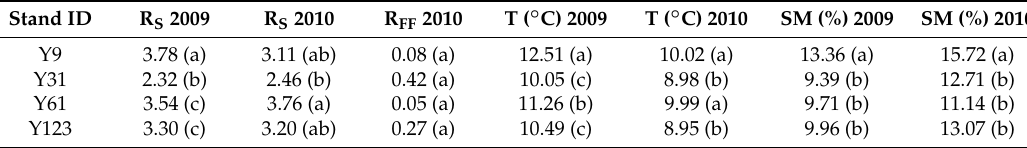
Table 3. Mean values of total soil respiration (R S ), volumetric soil moisture (SM), soil temperature (T), and forest floor respiration (R FF ) before experimental litter removal (2009) and after litter removal (2010) in red pine stands aged 9 (Y9), 31 (Y31), 61 (Y61), and 123 (Y123) years. Values represent annualized averages across multiple months of measurement in each year. R FF was calculated only after litter removal (i.e., only in 2010). Different letters indicate significant differences among treatments within a column. Respiration rates reported in µ mol CO 2 m − 2 s − 1